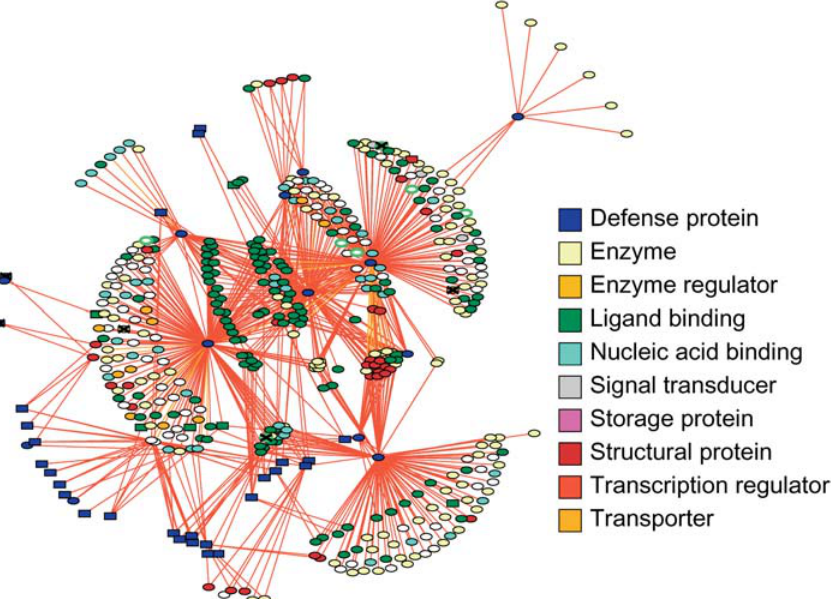
Figure 5. A Sample Bioverse-Predicted Interaction Network for Defense Proteins and Their Direct Neighbors The symbols are colored to indicate some of the major GO categories under ‘‘ molecular function. ’’ We draw a cross over the symbol for an NH gene. Rectangles indicate proteins that are manually classified as being R-genes. They appear on genes that are not colored as defense, because some genes have multiple functions, not because of an annotation error. The white circles with green outline are unannotated genes that might also belong to this network, at a lower confidence. DOI: